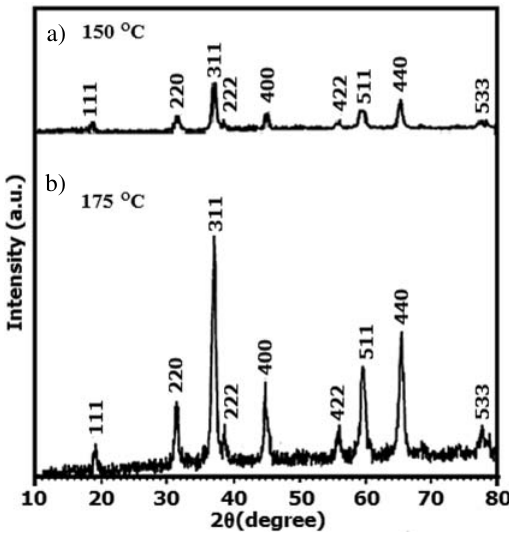
Figure 3. The XRD patterns for the decomposition product of [ Co(NH ) (H O) ] (NO ) complex at (a) 150 °C and (b) 175 °C. 3 5 2 3 3